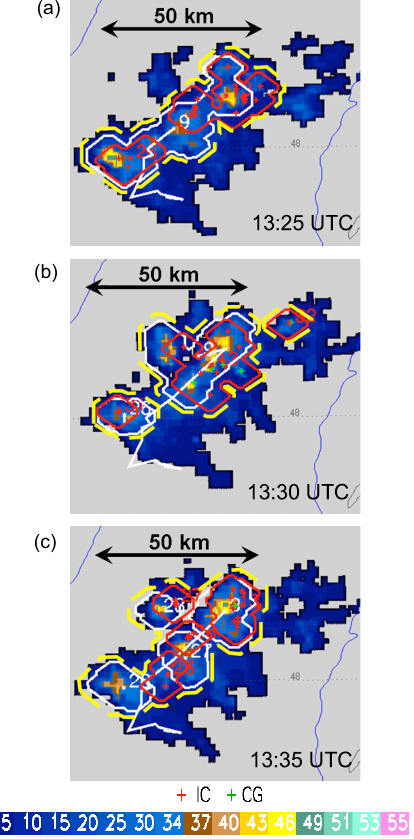
Fig. 5. Ec-TRAM snapshots showing a time sequence of the ex- ample storm recorded on 15 May 2008. Cell contours, cell centres, cell numbers, and the ec-TRAM cell tracks are shown. Lightning- cell parameters are red, radar-cell parameters white coloured. The cells identified and tracked by ec-TRAM are highlighted by yel- low dashed contours. The real outlines follow exactly the radar- and lightning-cell outlines. In this sequence, the identified radar- cell tracks determine the tracks recorded by ec-TRAM and therefore are drawn white. Electrical discharge events of 3min are indicated, CG events by green, IC events by red crosses. This storm undergoes an exceptionally complicated evolution, including multi-component cell structures (b) and several simultaneous cell splitting ( a to b ) and merging processes ( b to c